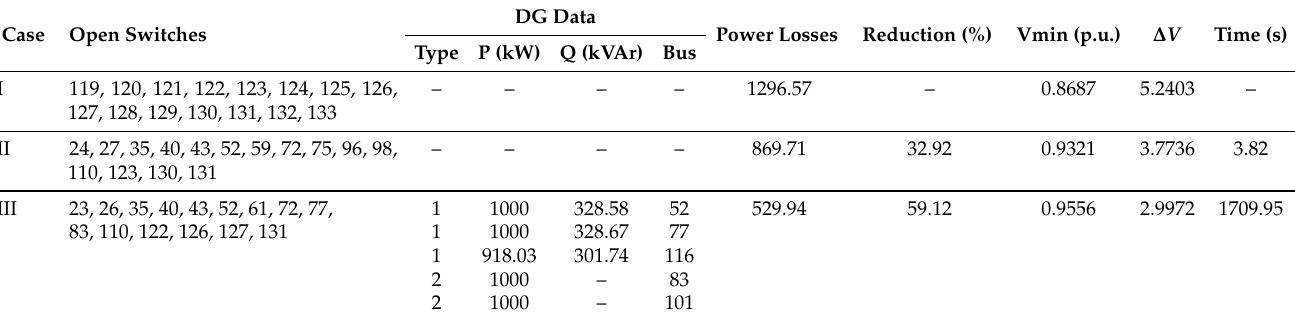
Table 6. Results for the 119-bus test system.